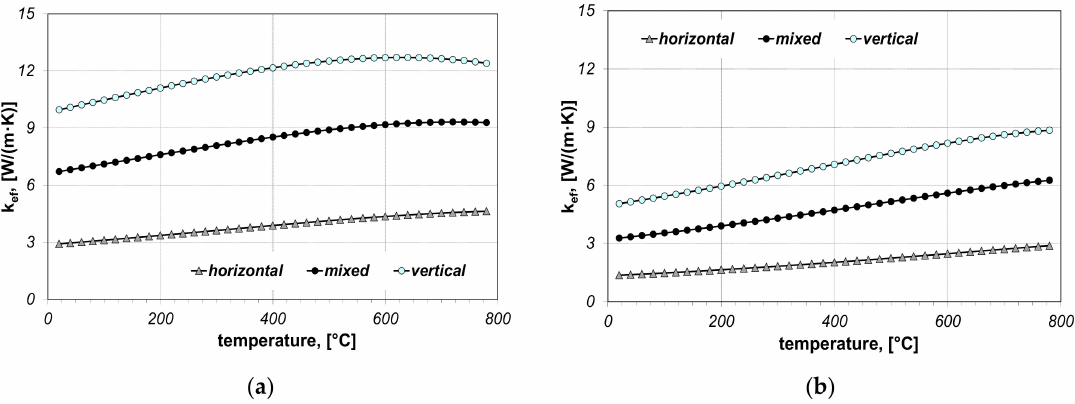
Figure 5. Calculated values of the coefficient k ef for the bundle of 10 × 40 mm bars: ( a ) results obtained for R ct-min , ( b ) results obtained for R ct-max